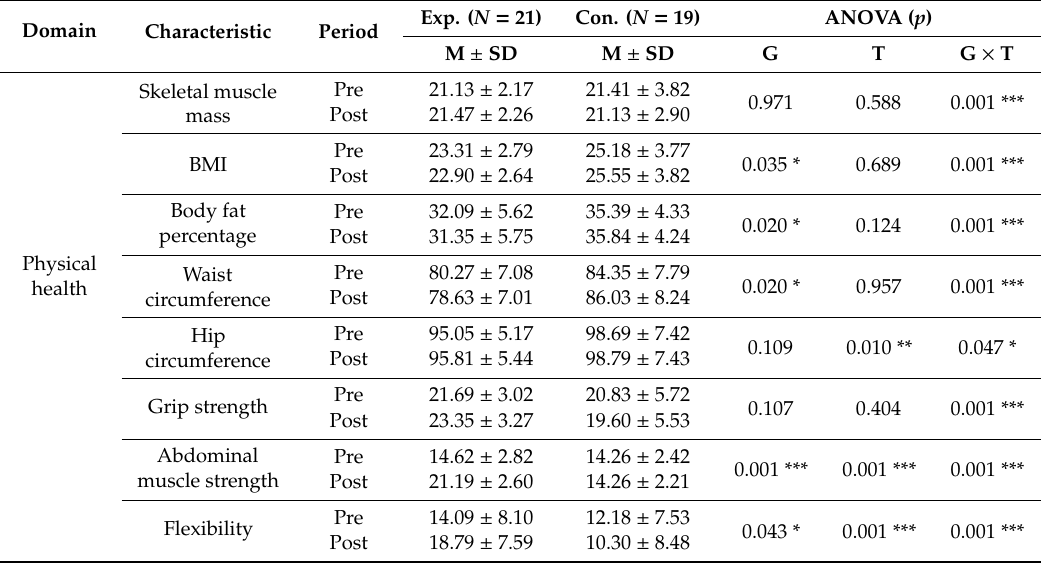
Table 4. Changes in physical health after participating in the SaBang-DolGi walking exercise program. Domain